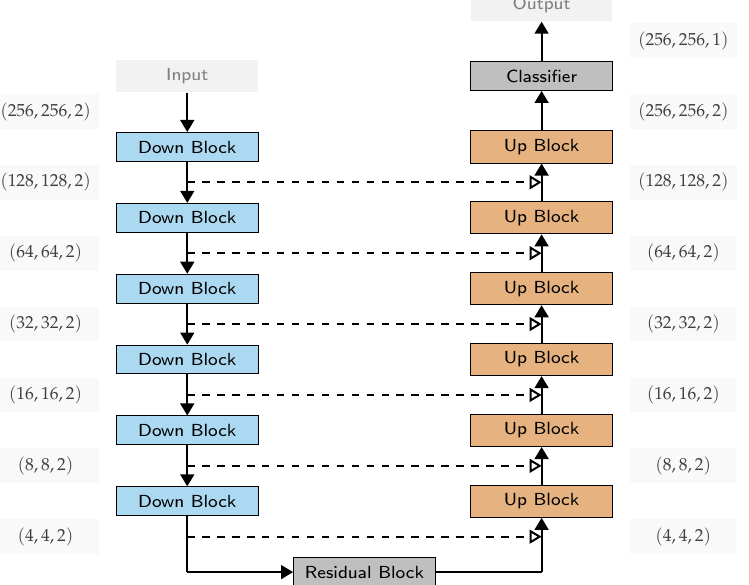
Figure 2. Illustration of the used network architecture, based on a U-Net with residual blocks. Depicted in light gray is the tensor size ( H , W , T ) between each block; the batch size and the number of channels have been omitted. Blue boxes correspond to down-sampling residual blocks, green boxes correspond to up-sampling residual blocks, and dark gray boxes correspond to residual blocks. Dashed lines indicate skip connections between the encoding and decoding phases of the U-Net. Solid lines indicate connections between layers.